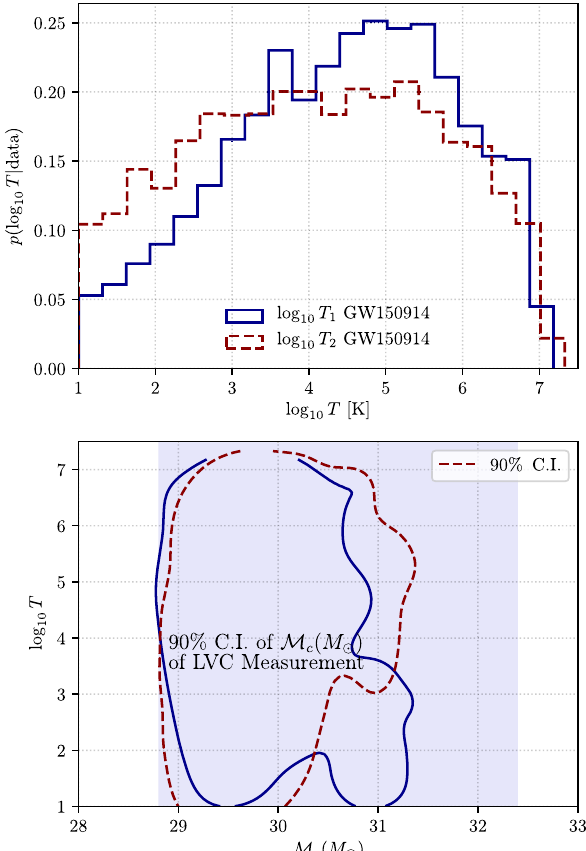
Fig. 1 Top panel: The marginalized posterior of log 10 T 1 (solid blue line) and log 10 T 2 (dashed red line) of the parental black holes of GW150914. The posteriors are of step-function shape as the detection of inspiral phase of GW150914 excludes completely the possibility of T eff > 10 7 K. Bottom panel: 90% confidence contour of the two- dimensional posterior of log 10 T 1 (solid blue line) and log 10 T 2 (dashed red line) vs. M c , the chirp mass in the detector frame. The contours show thattherearenostrongcorrelationsbetweenlog 10 T 1 (orlog 10 T 2 ) and M c . The shaded region shows the 90% percentile of M c of the first